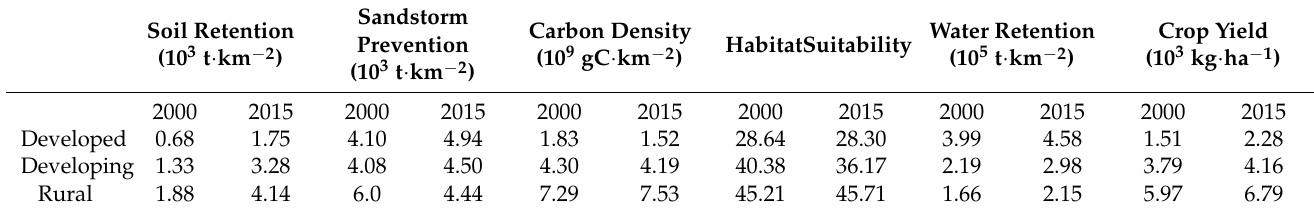
Table 4. Mean values of ESs in the three urban areas.